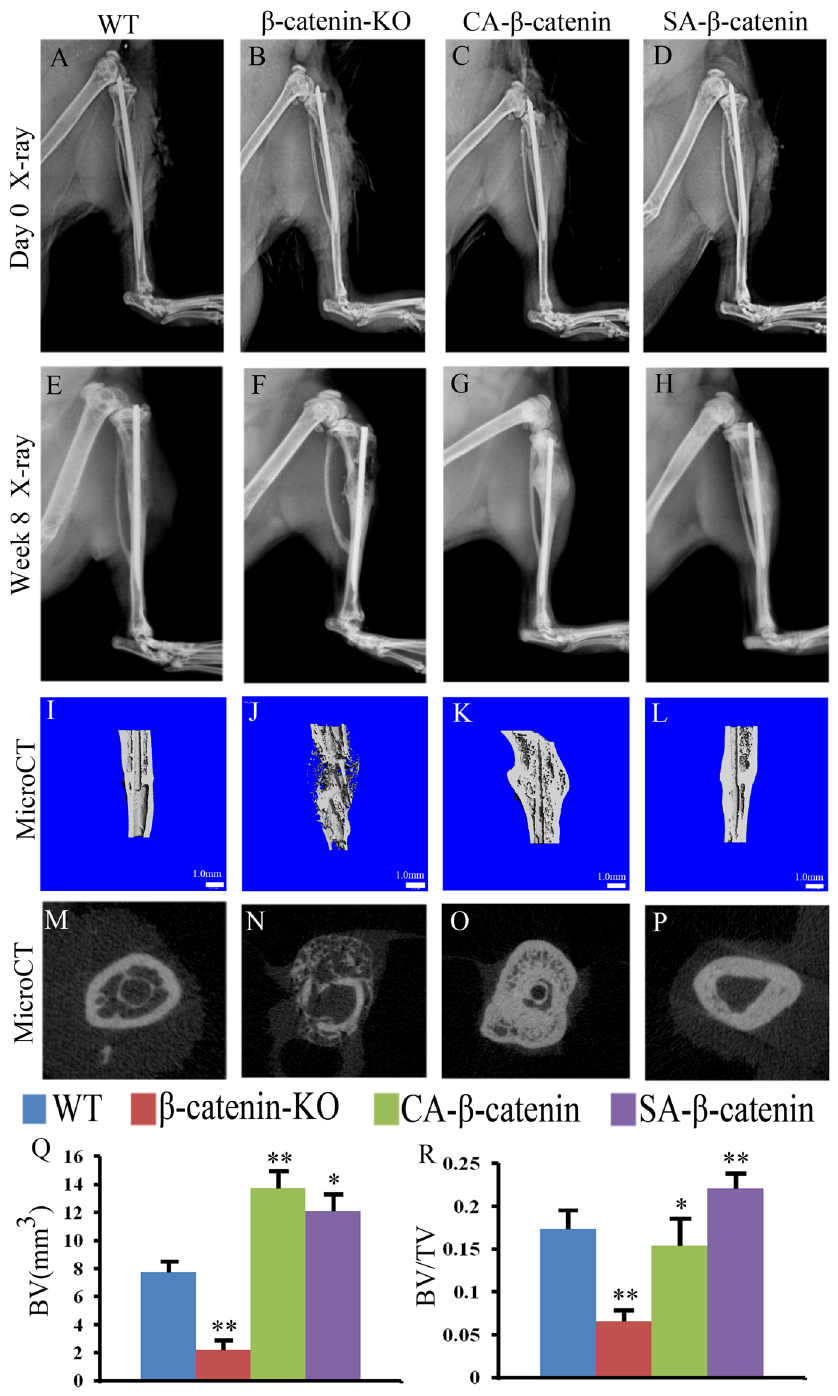
Figure 2. X-ray radiology and MicroCT examinations revealed that slight activation of β -catenin in the remodeling phases could improve healing quality. Representative X-ray radiographs of fracture sites in WT, β -catenin-KO, CA- β -catenin and SA- β -catenin mice at day 0 ( A – D ) and week 8 ( E – H ) post-fracture. ( I – L ) and ( M – P ) Representative 3-D and 2-D transverse reconstructive μ CT-images in WT, β -catenin-KO, CA- β -catenin and SA- β -catenin mice at 8weeks post-fracture. ( Q and R ) Quantitative BV and BV/TV in WT, β -catenin-KO, CA- β -catenin and SA- β -catenin mice at week 8 post-fracture. The values are expressed as the means ± SDs. * p < 0.05, ** p < 0.01 (Scale bar = 1 mm in I–L , n =